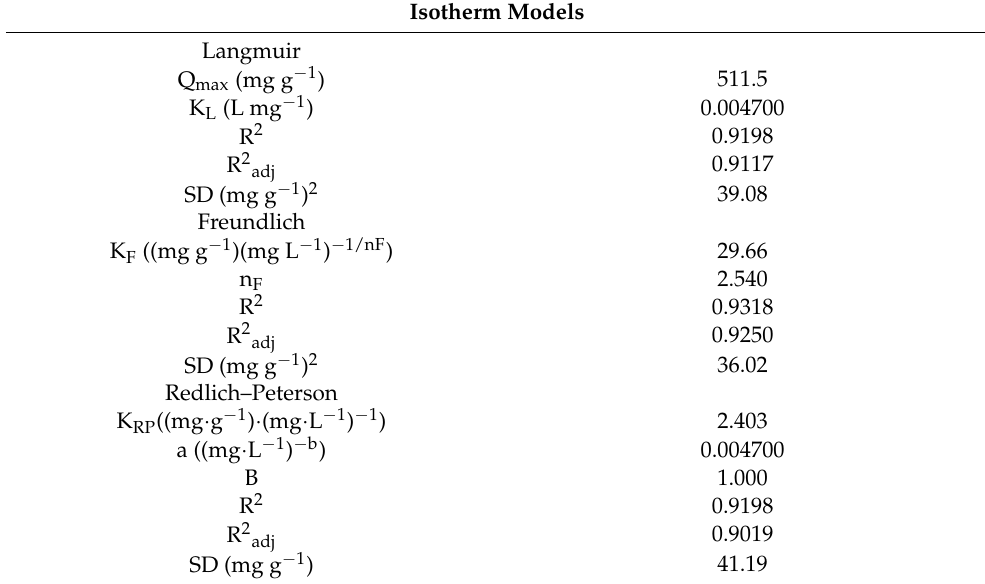
Figure 12. Adsorption isotherms of BC6 and the fitted models. Table 5. Isotherm fitting parameters .